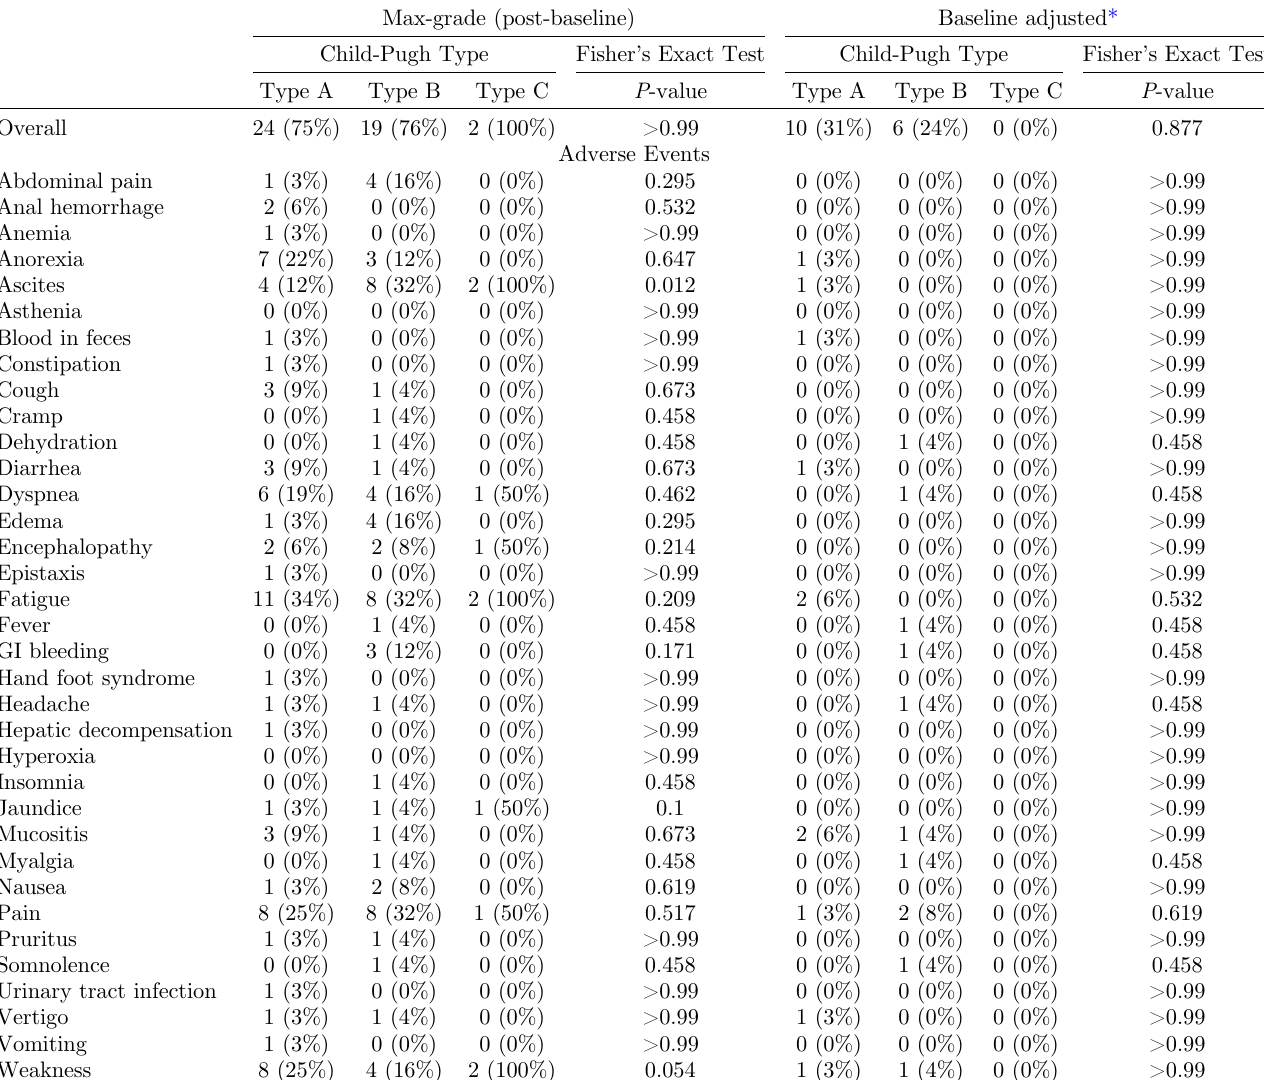
Table 7. Incidence of any grade adverse events by Child-Pugh Type. Adverse Events reported by Child-Pugh type in patients receiving treatment with the TheraBionic device. Fisher ’ s exact test used for statistical comparison of reported incidence of AEs. Statistical signi fi cance in adverse event incidence reported at a 0.05 signi fi cance